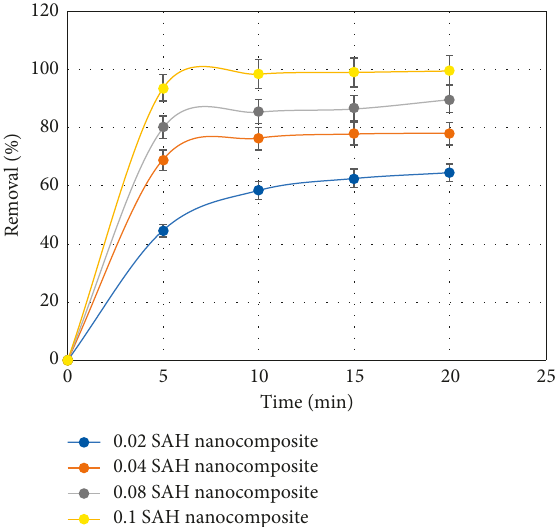
Figure 10: The effect of dosage of the NSG nanocomposite on the adsorption of 10mg · L − 1 EBTdye at a pH of 3 and a contact time of